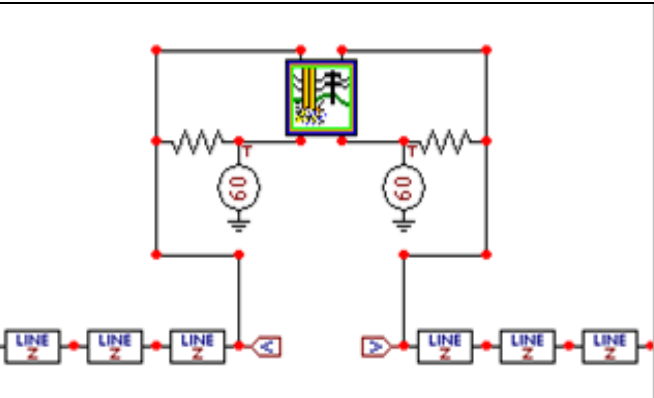
Figura 3: Equivalente circuital modelo de tensiones inducidas por descargas indirectas.